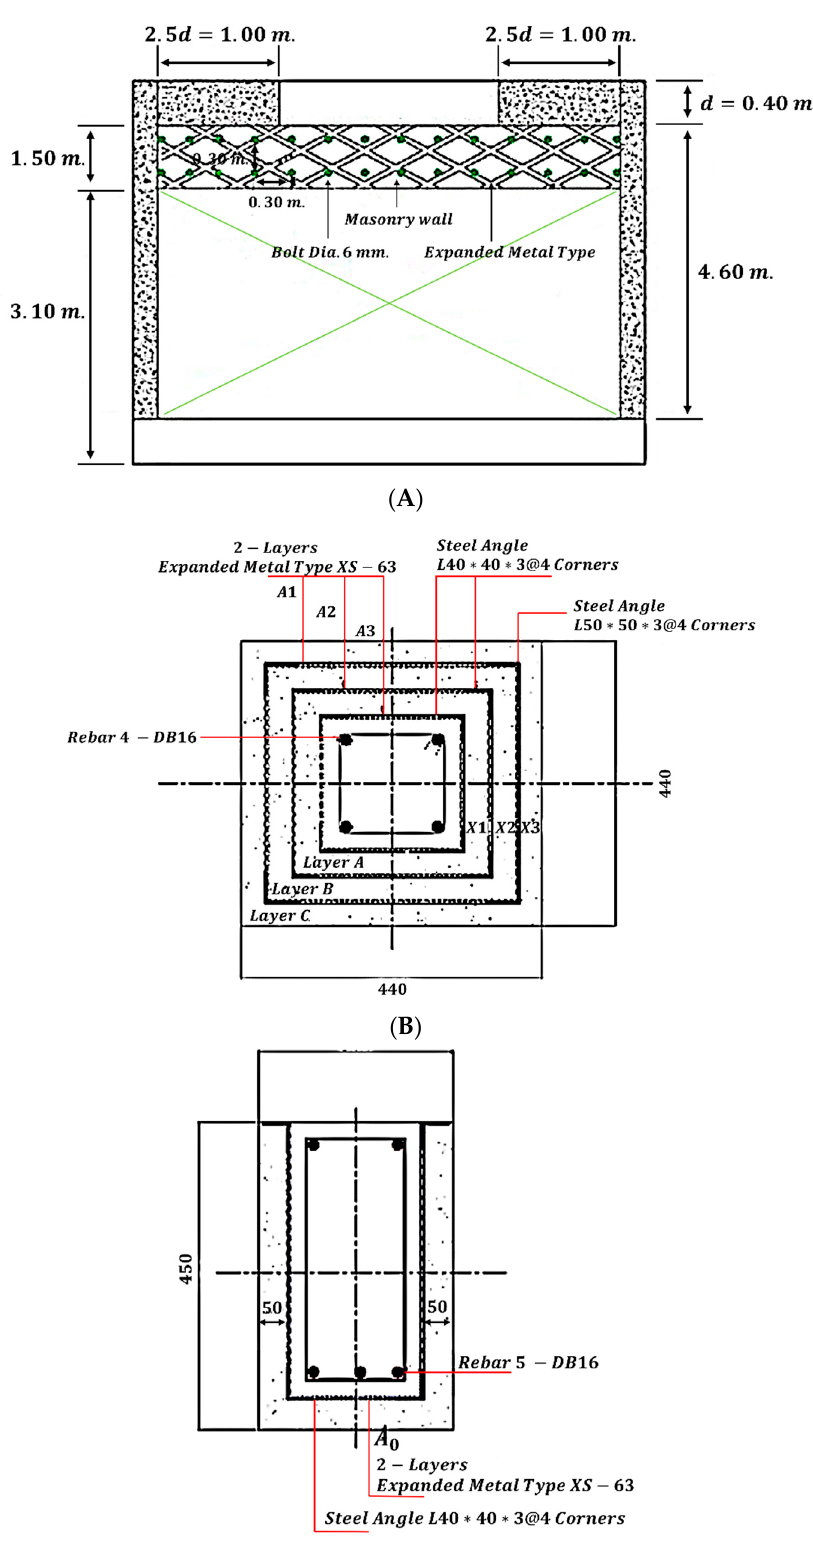
Figure 5. Wall, column, and beam reinforced with expanded metal. ( A ) Single-span reinforced building frame; ( B ) Cross-section of the reinforced column; ( C ) Cross-section of the reinforced beam.